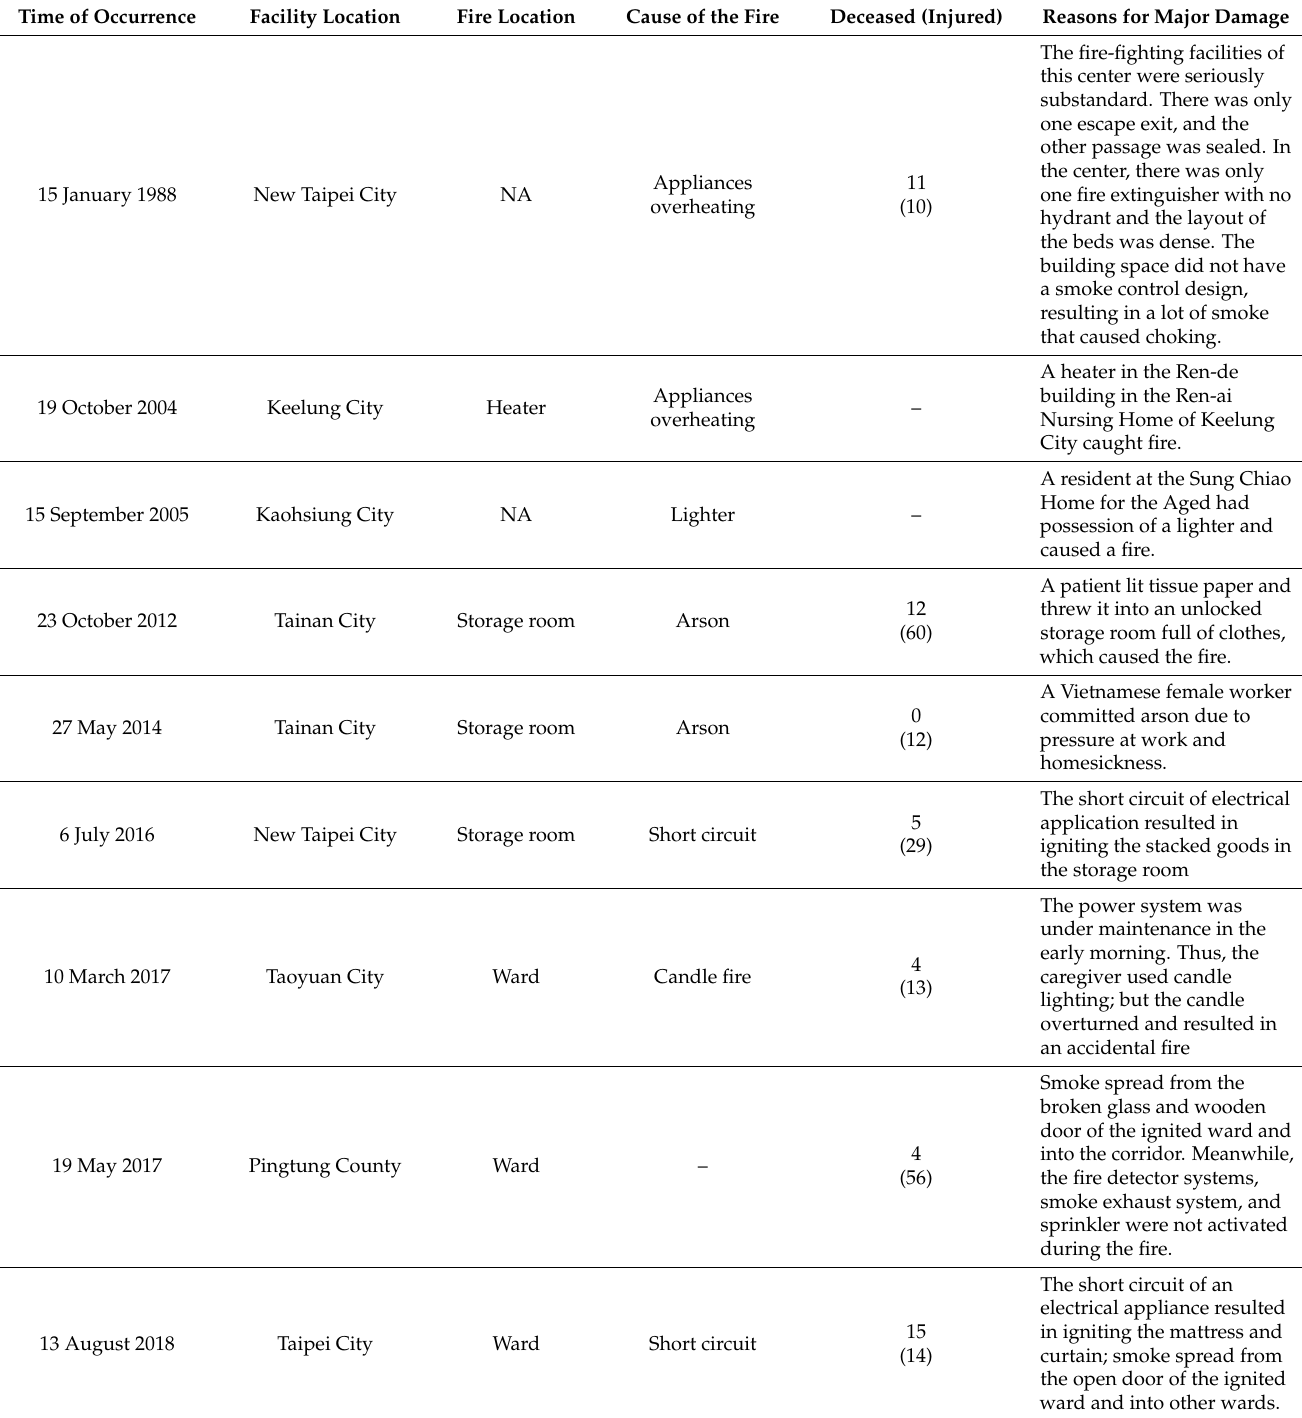
Table 1. The cases of fire occurring in nursing homes in